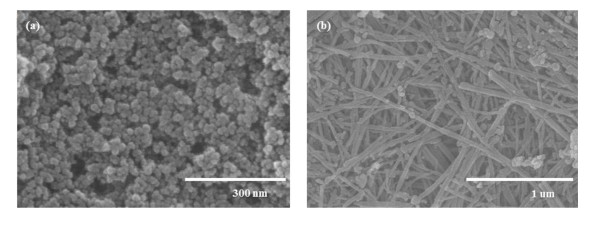
FE-SEM images of TiO2 nanoparticles and TNT films. (a) TiO2 nanoparticles made by the sol-gel method and (b) TNT films made by the hydrothermal method at 150°C for 12 h.